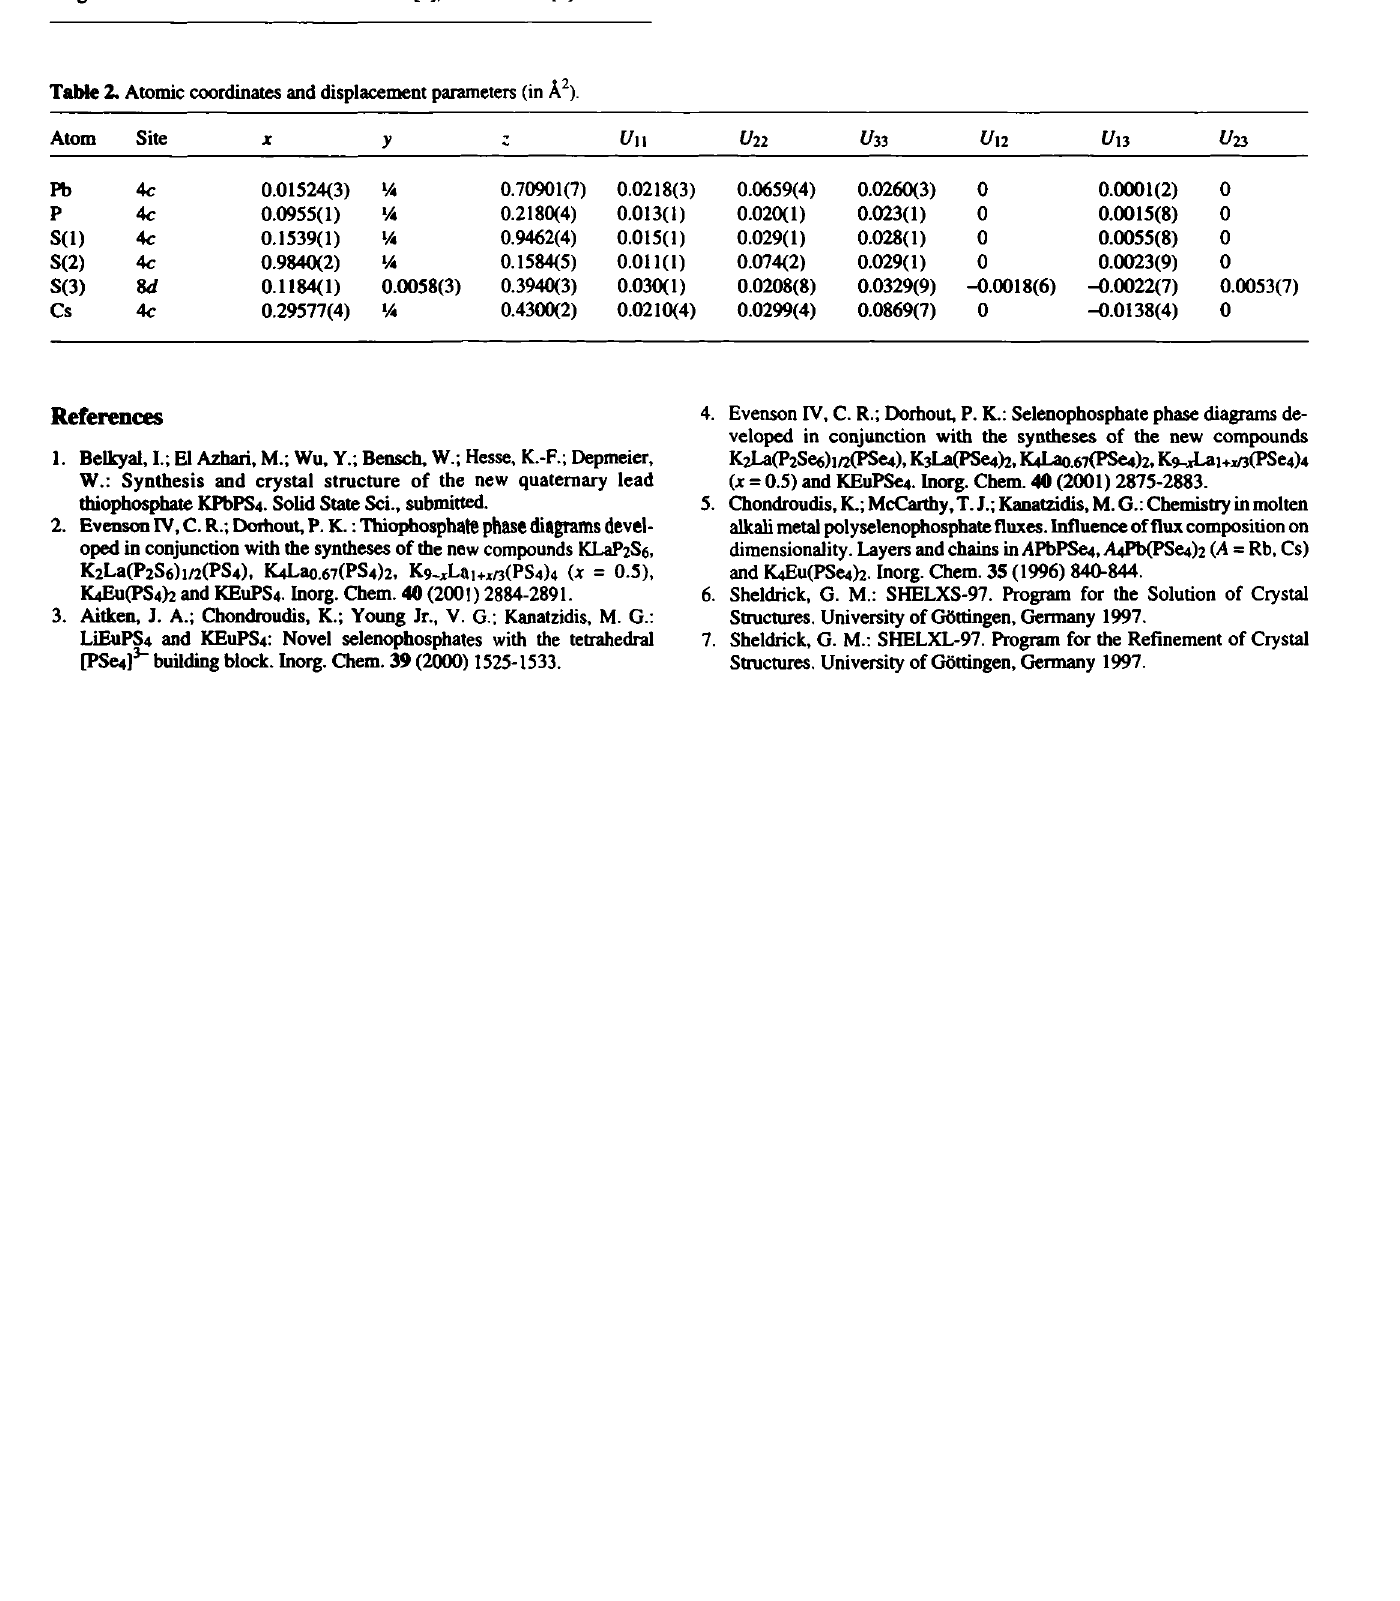
Table 2. Atomic coordinates and displacement parameters (in A 2